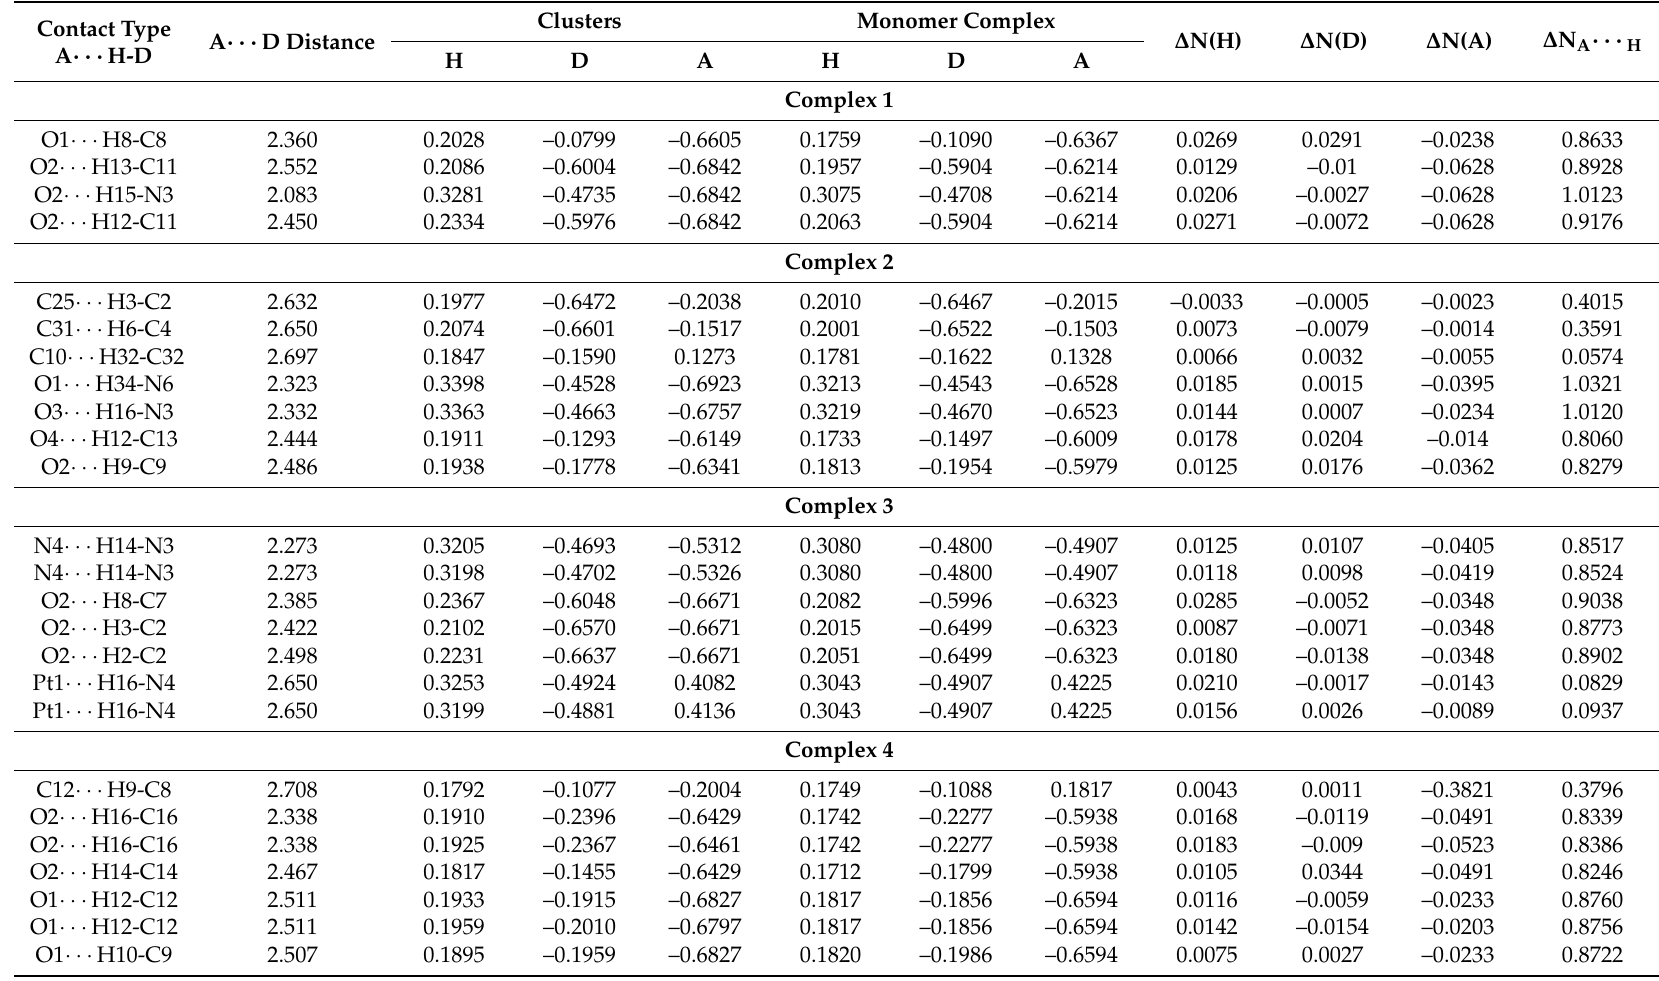
Table 3. Calculated natural charges at the D-H · · · A sites using the B3LYP